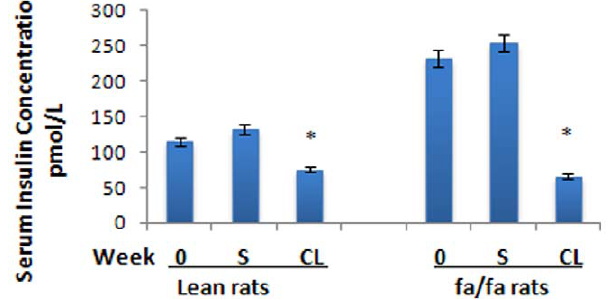
Figure 2. Serum insulin concentration. CL- fa/fa vs S- fa/fa after 4 weeks of treatment, P , 0.001 . CL-lean vs S-lean after 4 weeks of treatment, P , 0.001 . Serum insulin level is higher in fa/fa rats than in lean rats at week 0 and in S- fa/fa , P , 0.001 . Serum insulin level decreased significantly in CL-lean as compared with S-lean, P , 0.001 . There is no significant difference between CL- fa/fa CL-lean rats after 4 weeks treatment.